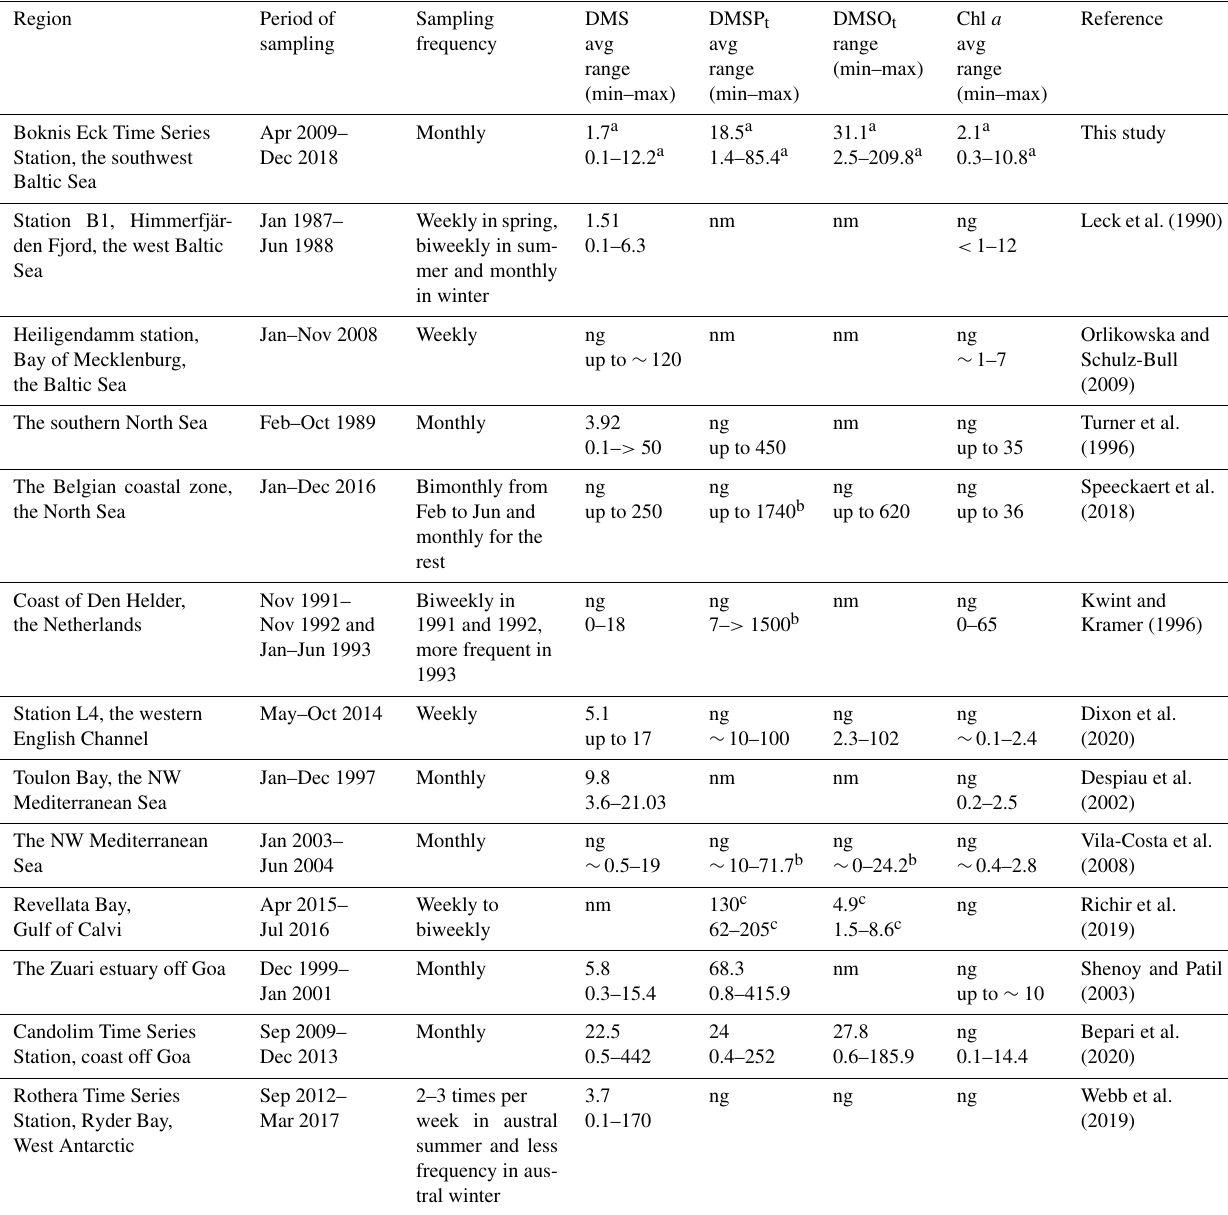
Table 2. Surface sulfur compound concentrations from coastal time-series studies.